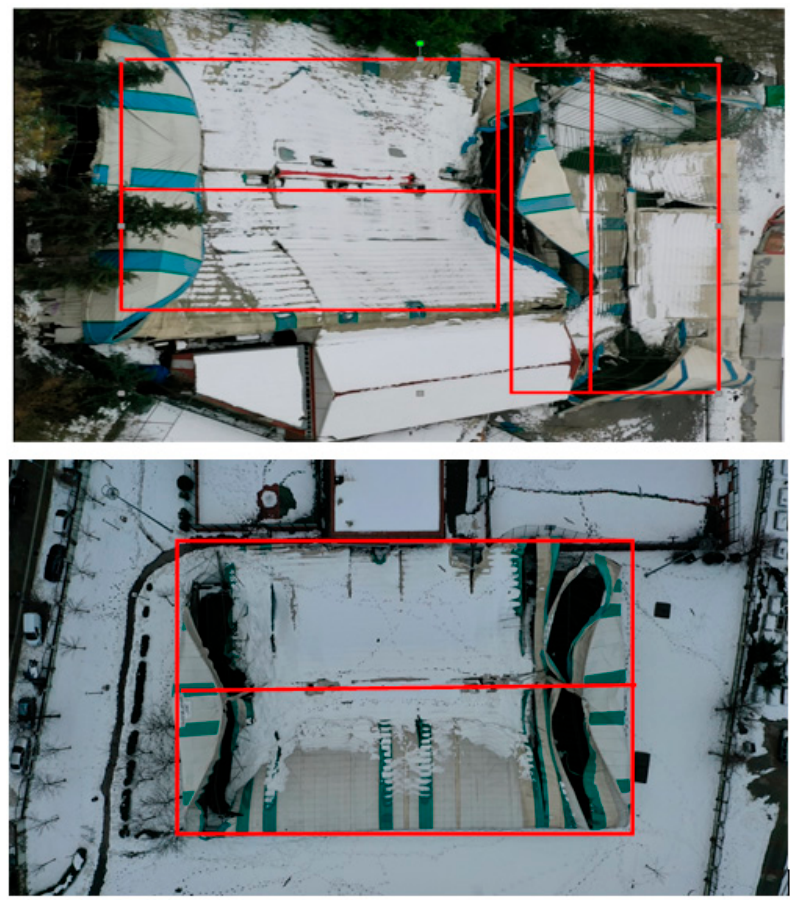
Figure 3. Top views of the collapsed structures.